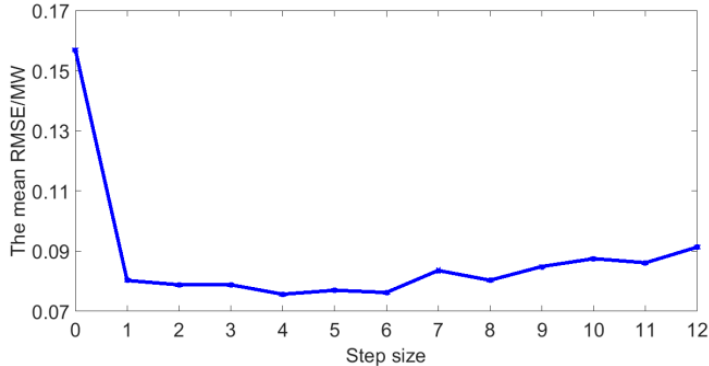
Figure 6. The root mean square error (RMSE) of photovoltaic power in different step size.